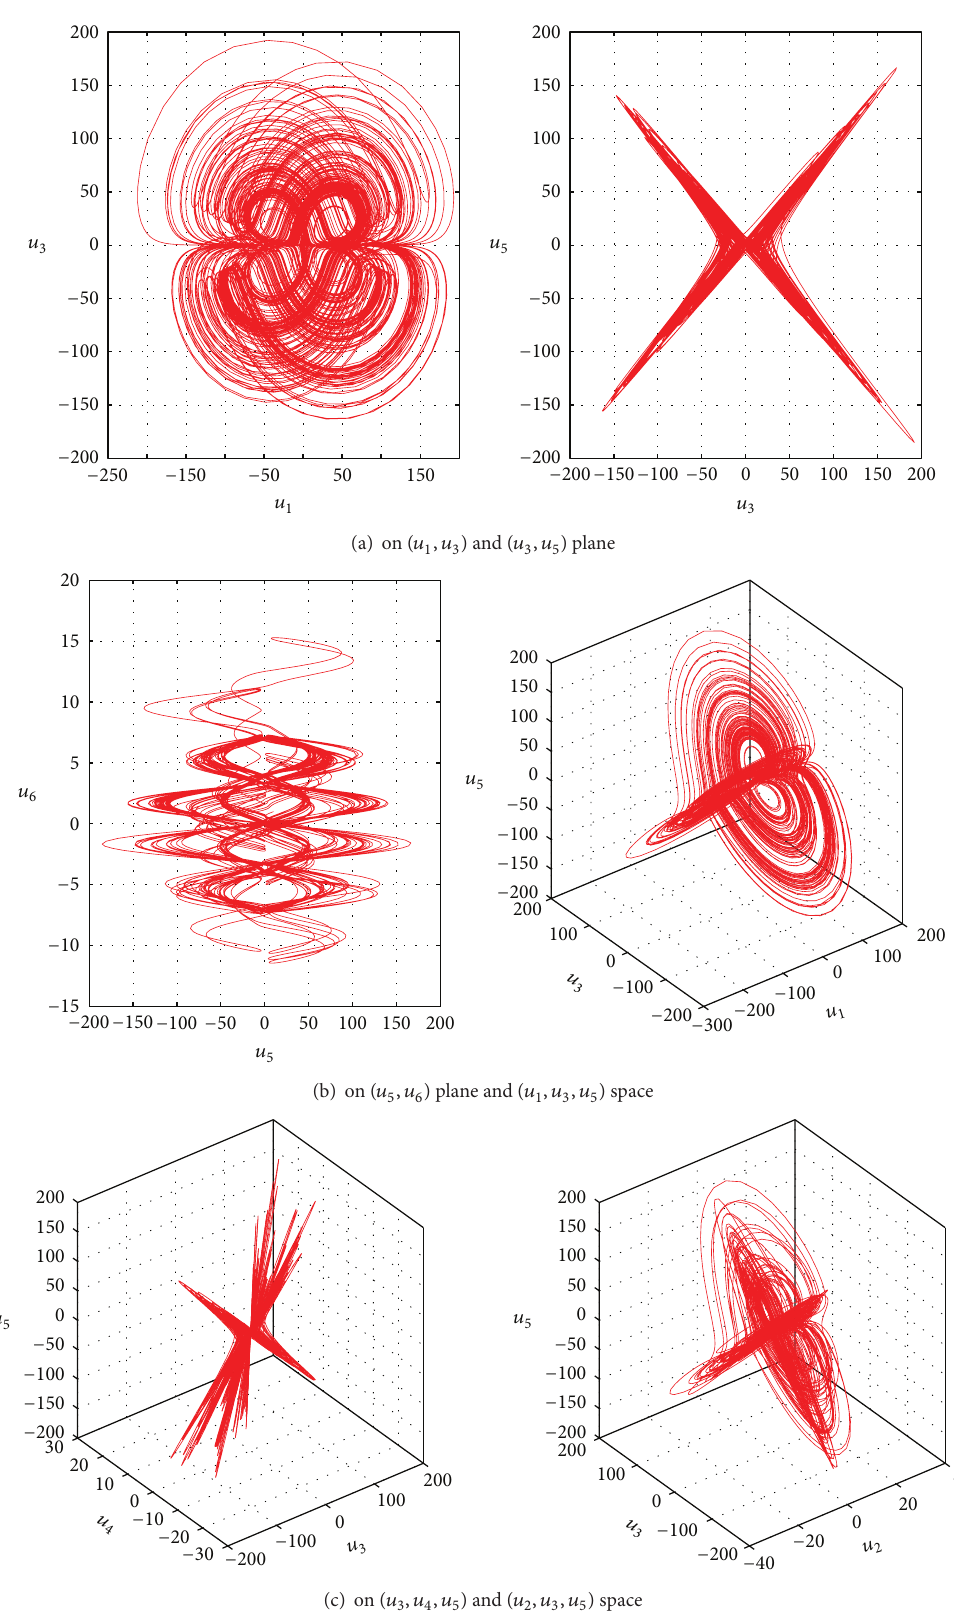
(c) on ( 𝑢 3 ,𝑢 4 ,𝑢 5 ) and ( 𝑢 2 ,𝑢 3 ,𝑢 5 ) space Figure 4: The chaotic attractors of complex Dadras system (5) with 𝑎 = 10 , 𝑏 = 40 , and 𝑐 = 49